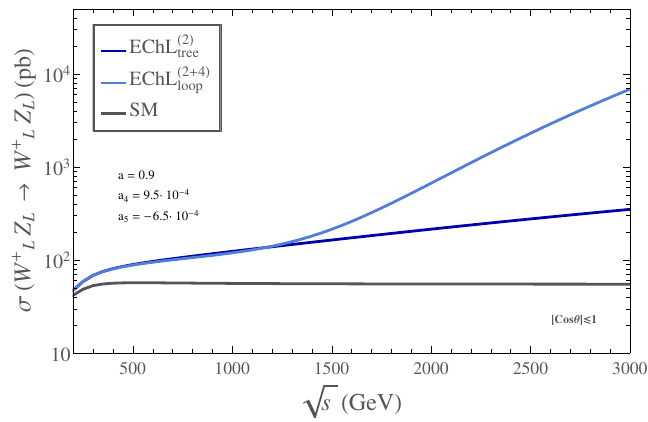
Figure 2 . Predictions of the cross section (cid:27) ( W L Z L ! W L Z L ) as a function of the center of mass energy p s from the EChL. The predictions at leading order, EChL (2) , and next to leading tree order, EChL (2+4) , are displayed separately. The EChL coe(cid:14)cients are set here to a = 0 : 9, b = a 2 , loop a 4 = 9 : 5 10 (cid:0) 4 and a 5 = 6 : 5 10 (cid:0) 4 . Here the integration is done in the whole cos (cid:18) 1 interval (cid:2) (cid:0) (cid:2) j j (cid:20) of the centre of mass scattering angle (cid:18) . The prediction of the SM cross section is also included, for comparison. All predictions have been obtained using FormCalc and our private Mathematica code and checked with